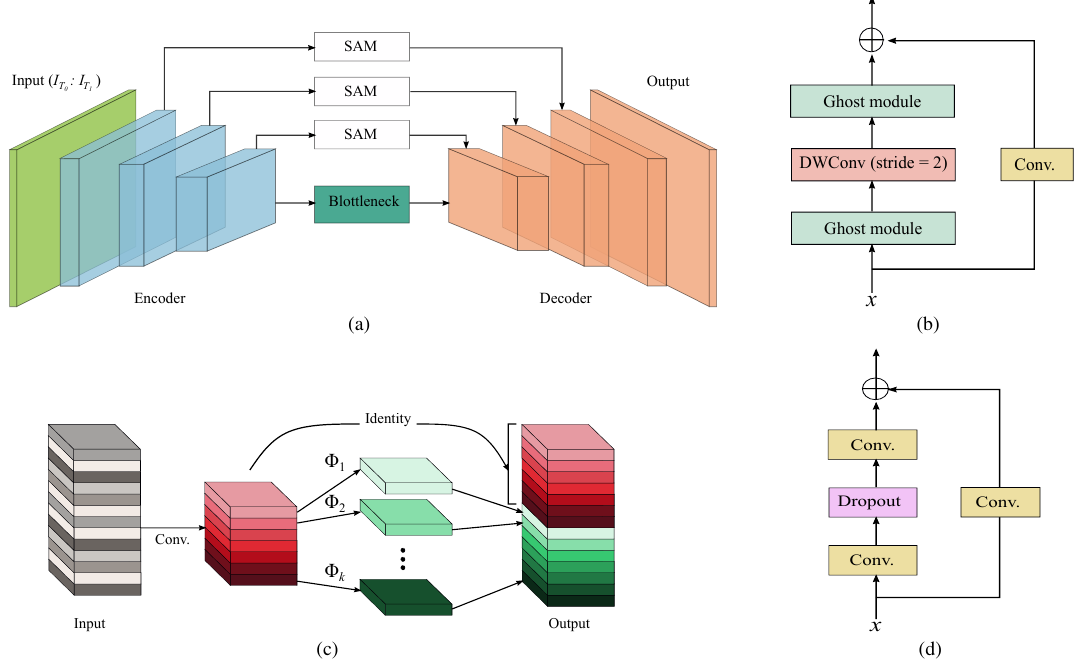
Figure 1. (a) Multi-attention DL architecture. (b) Ghost block, (c) Ghost module, Φ represents the cheap operations. (d) Residual